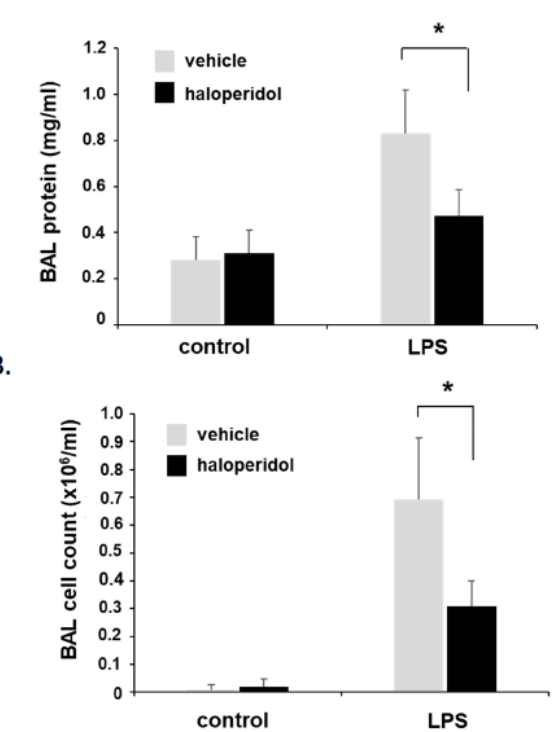
Figure 5. Murine ALI is attenuated by haloperidol: BAL fluid protein and cell counts. Mice were pretreated with haloperidol (4 mg/kg, IP) or vehicle 24 h prior to repeat treatment of the same, followed by the administration of intratracheal LPS (1.25 mg/kg). BAL fluid was collected 24 h later and assessed for ( A ) total protein content and ( B ) total cell counts ( n = 5/LPS groups, * p < 0.05).